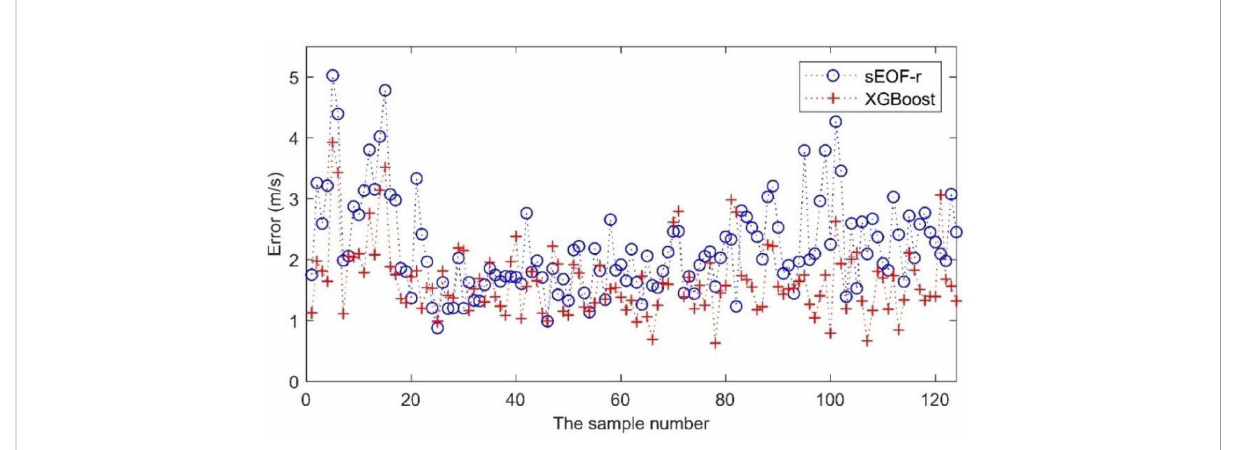
FIGURE 4 Reconstruction error of two models for different